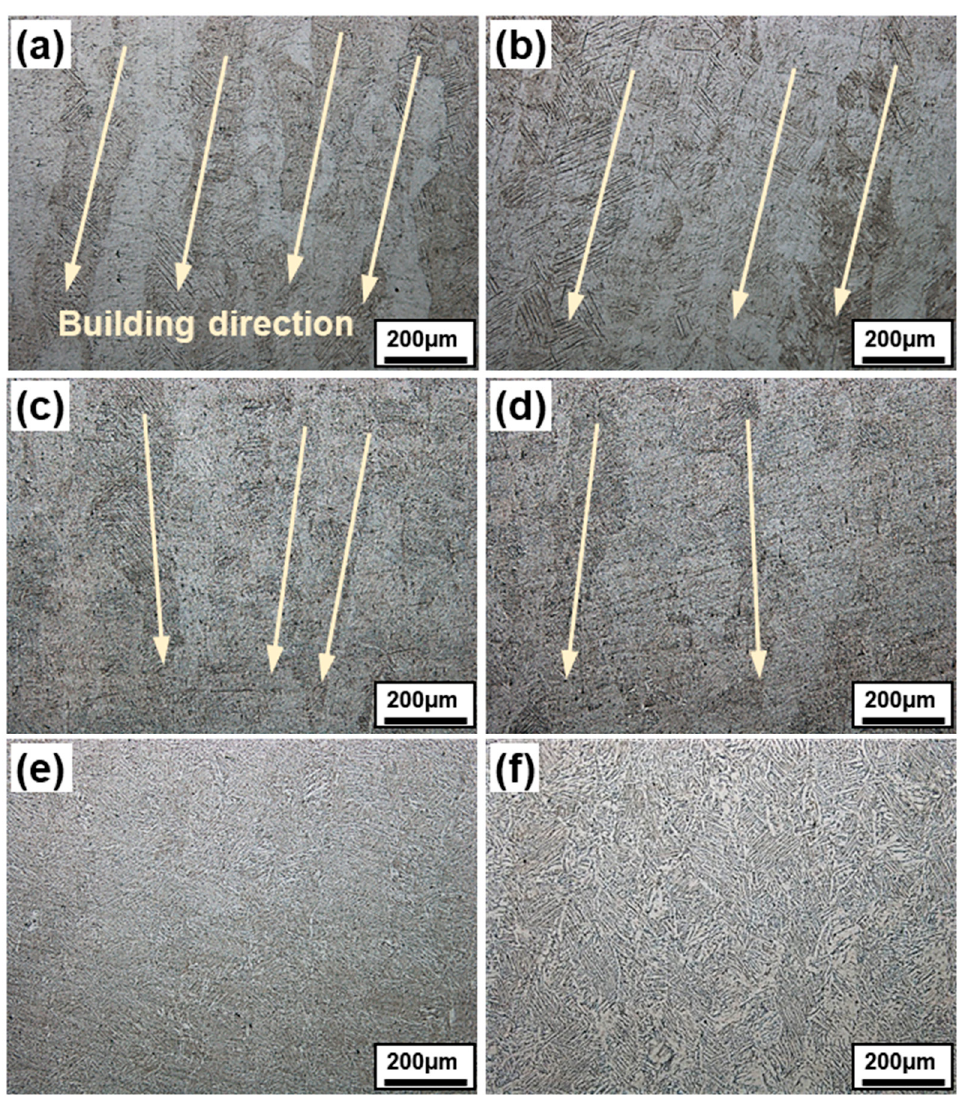
Figure 3. Optical micrographs of SLM Ti ‐ 6Al ‐ 4V alloy in as ‐ built and heat ‐ treated conditions. ( a ) As ‐ built, ( b ) 650 °C, ( c ) 750 °C, ( d ) 800 °C, ( e ) 900 °C, and ( f ) 1000 °C .